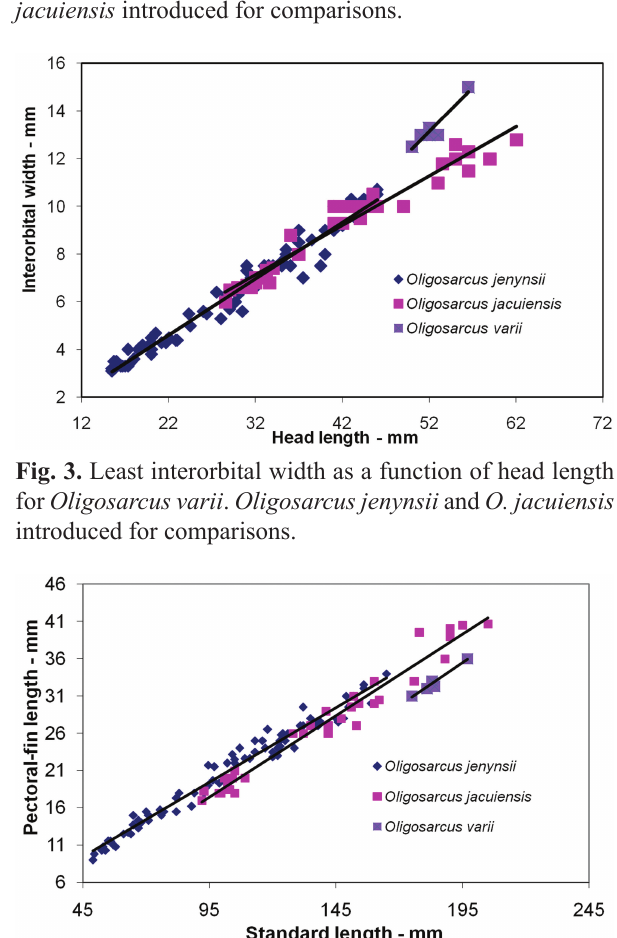
Fig. 4. Pectoral-fin length as a function of standard length for Oligosarcus varii . Oligosarcus jenynsii and O. jacuiensis introduced for comparions.